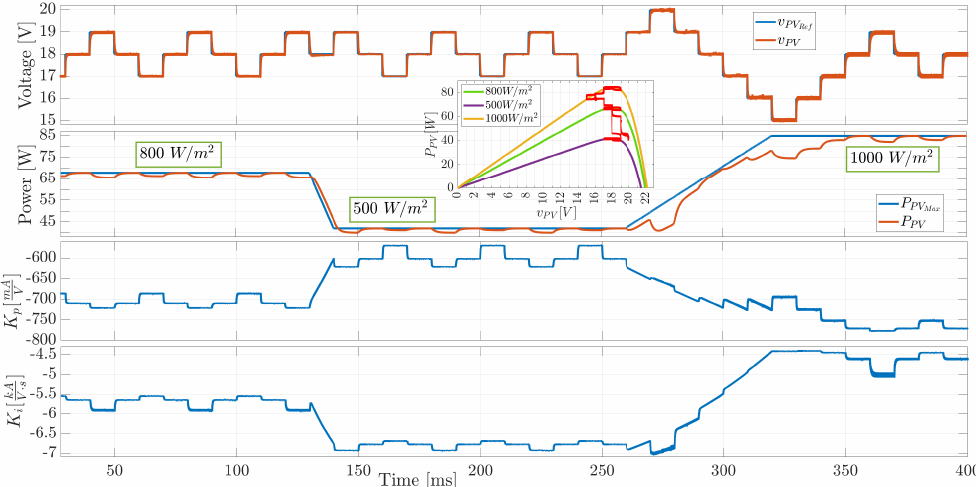
Figure 17. System performance for changes on the irradiance and MPPT